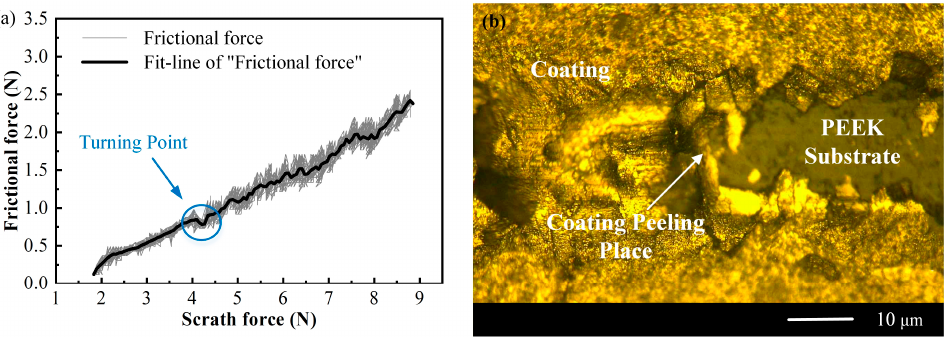
Figure 6. Effect of scratch test: ( a ) friction-normal load curve; ( b ) micromorphology of coating peeling place.